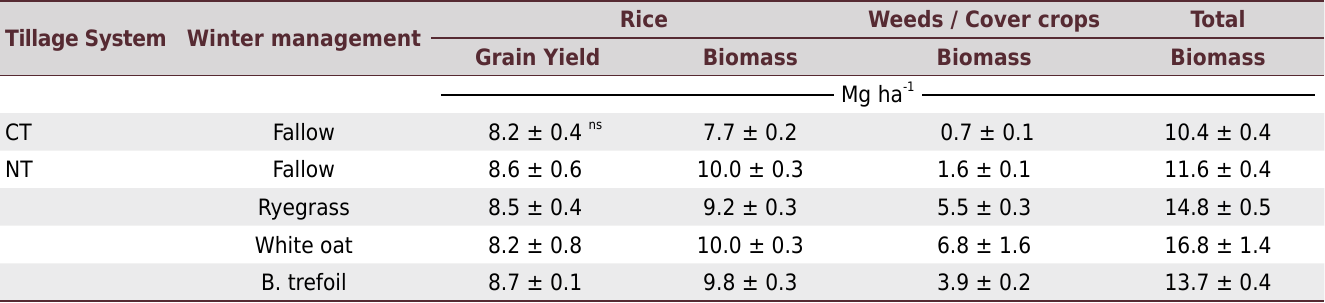
Table 3. Rice grain yield, biomass input by rice, cover crops and weeds in different winter managements (fallow or cover crops) combined with conventional tillage (CT) or no-tillage (NT) in a subtropical Gleysol subjected to flooding rice production in Southern Brazil Tillage System Winter